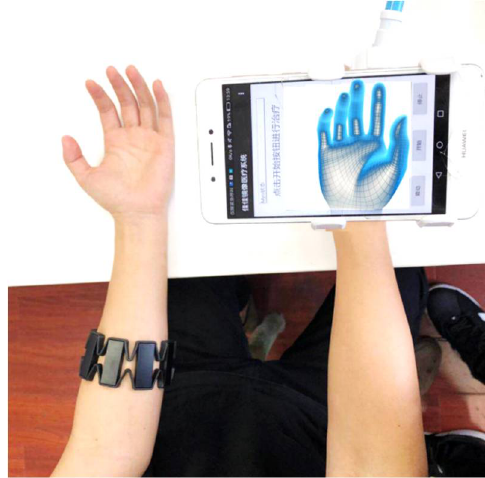
Figure 12. The real mirror therapy system.